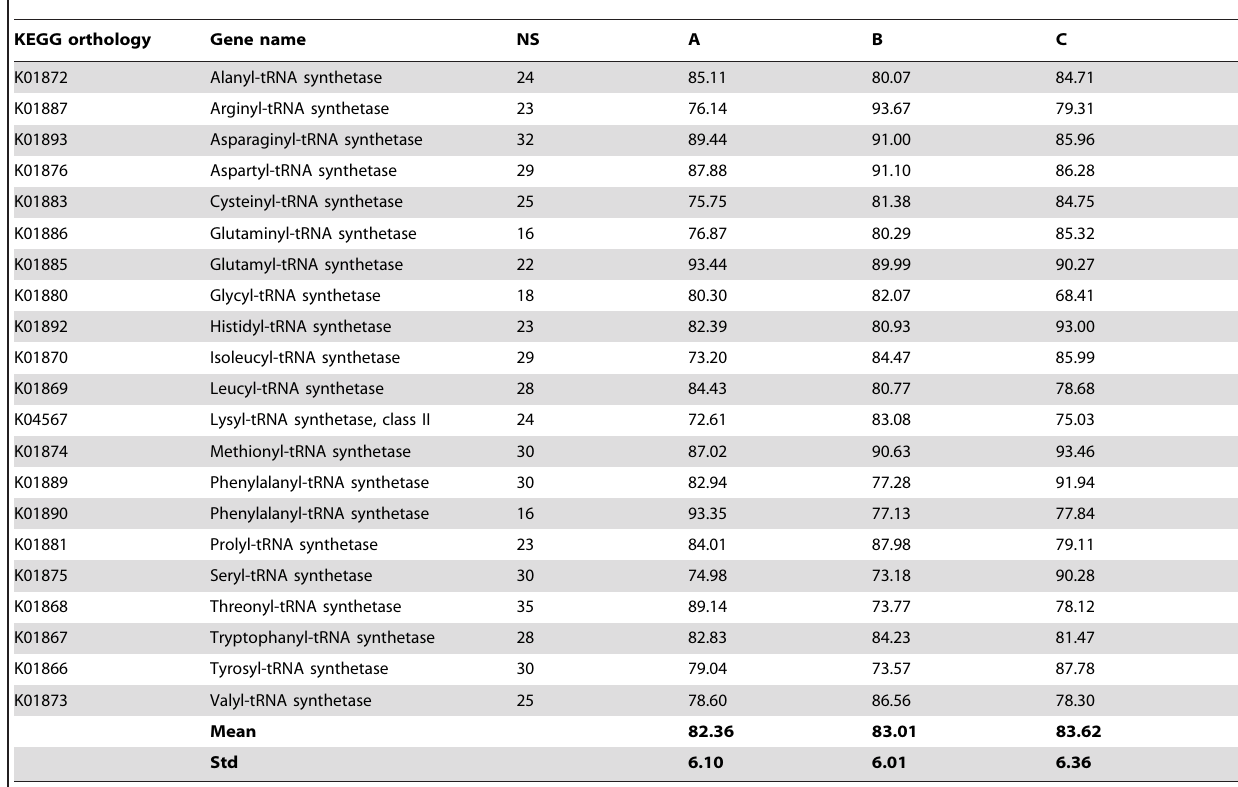
Table 3. Similarity scores for tRNA synthetase genes.